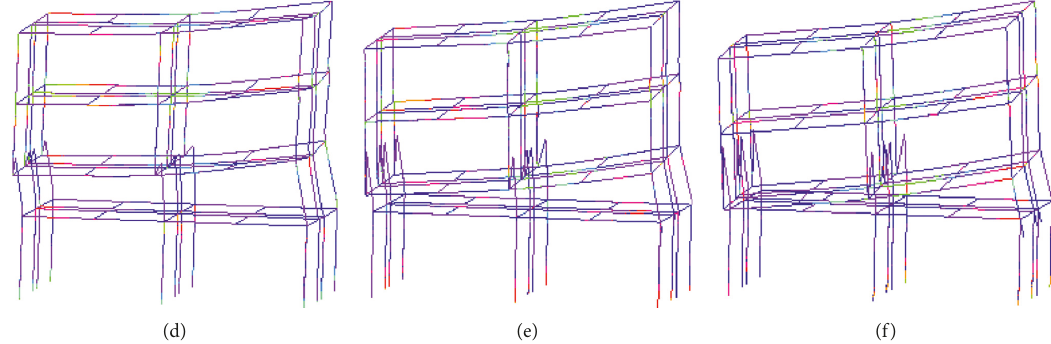
Figure 10: Collapse process of the structure subjected to three-component excitation under Taft wave. (a) t � 9.0s. (b) t � 9.5s. (c) t � 10.0s.